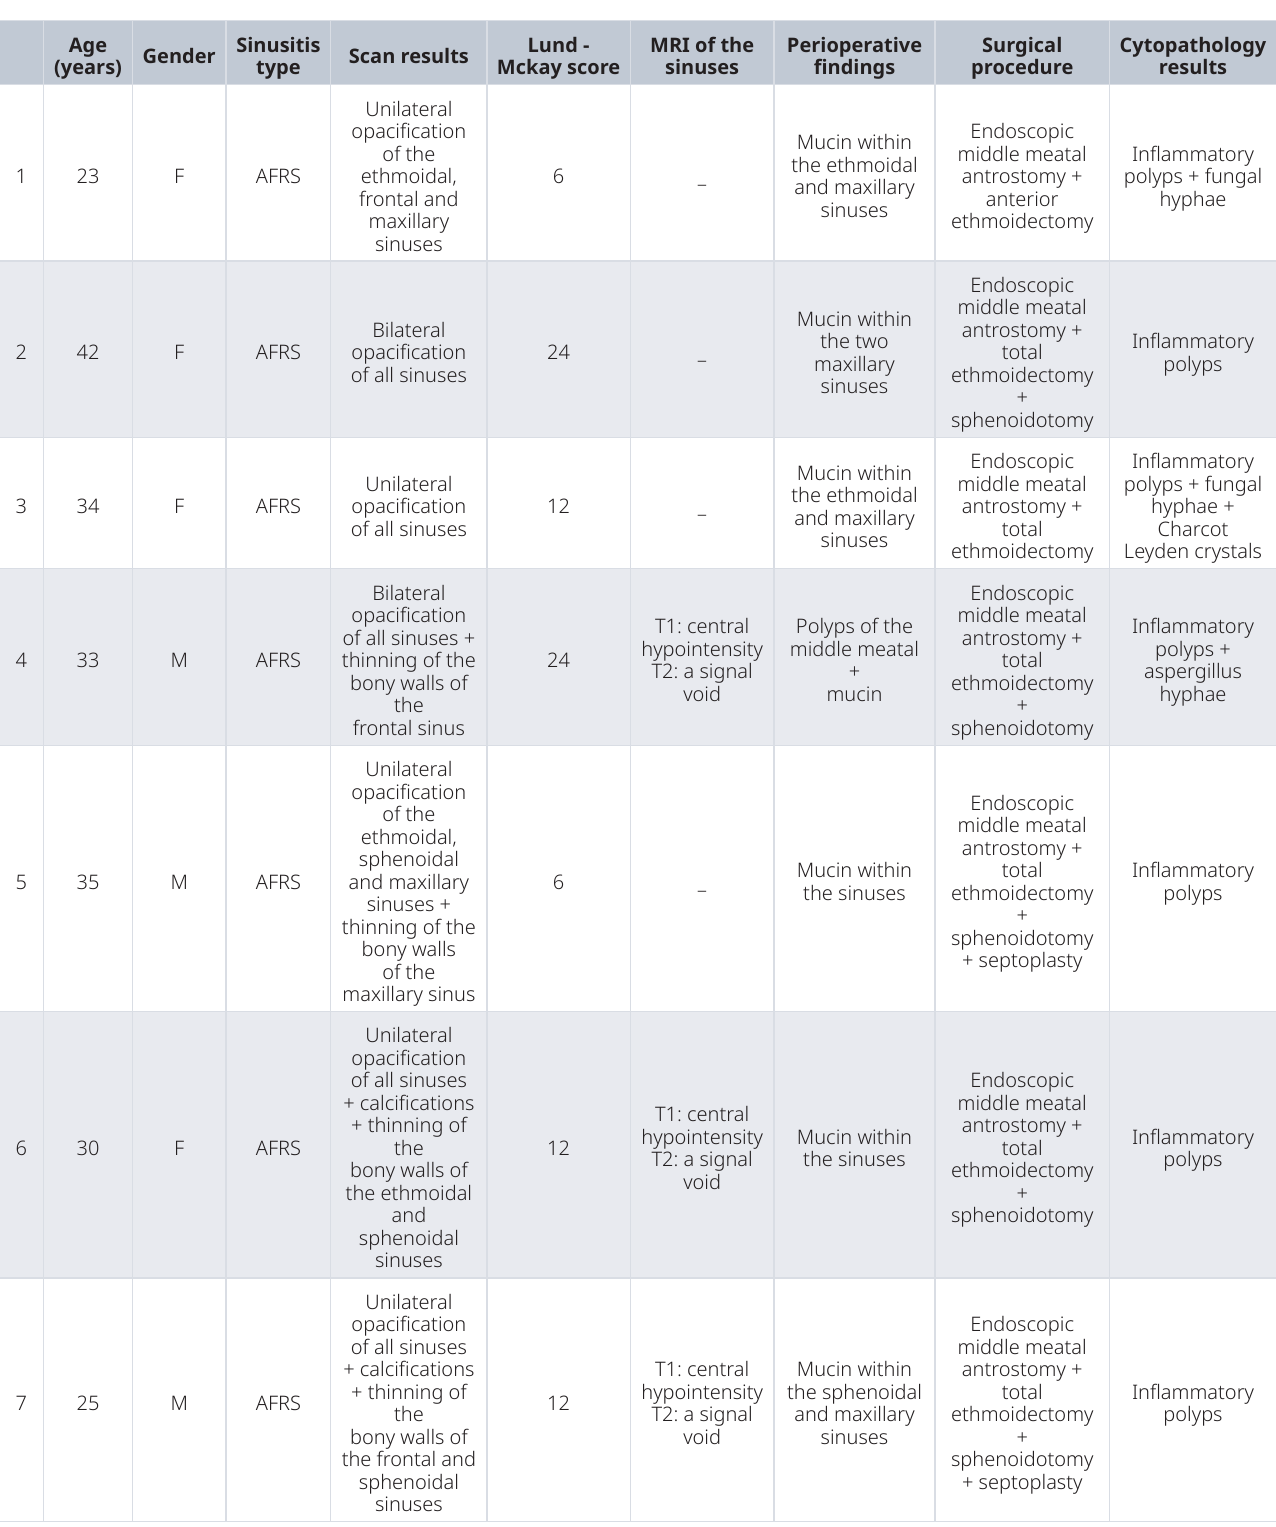
Table 1. Report of the 11 cases of noninvasive fungal rhinosinusitis. Age Sinusitis Gender (years)